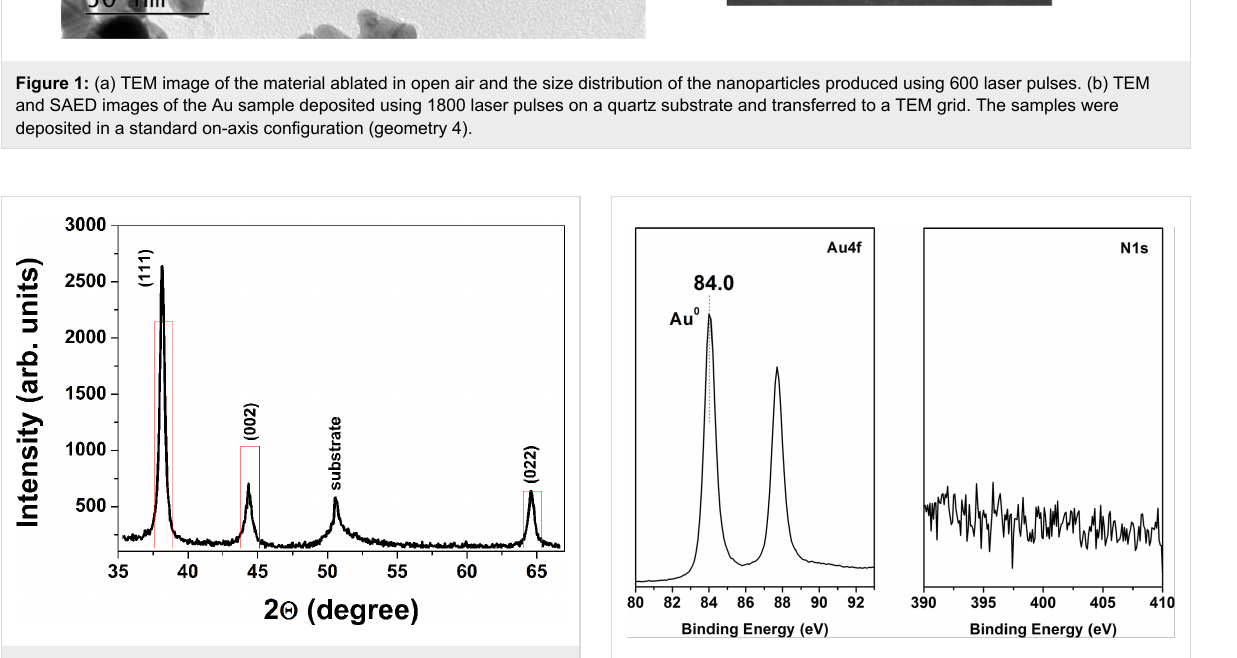
Figure 2: XRD pattern of a Au nanostructure produced by PLD in open air under standard on-axis configuration (geometry 4) compared with theoretically calculated XRD patterns of Au (red